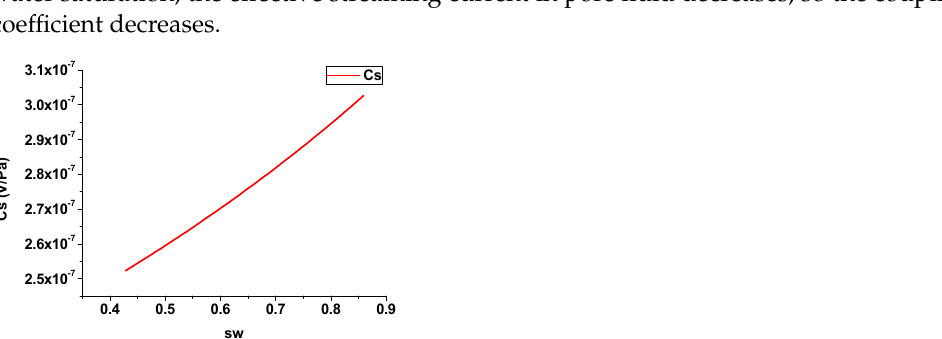
sw Cs1 Cs2 Cs3 Cs4 Cs5 Figure 9. Influence of water film thickness on streaming potential coupling coefficient (slug flow). Figure 10 studies the influence of pore size on the streaming potential coupling coef- ficient of the capillary under slug flow. The pore radius is taken as 0.2 μm , 0.4 μm , 0.6 μm , 0.8 μm , and 1 μm , respectively. It can be seen from the figure that the coupling coeffi- cient gradually increases with the increase in pore radius. As the pore radius increases, the streaming current will increase, and the change in pore fluid conductivity is small, so the coupling coefficient will become larger. 0.5 sw Cs1 Cs2 Cs3 Cs4 Cs5 Figure 10. Influence of pore size on streaming potential coupling coefficient (slug flow). Figure 11 investigates the effect of fluid salinity on the streaming potential coupling coefficient of the capillary in the slug flow case. The salinity is taken as 0.015 mol/L, 0.03 mol/L, 0.045 mol/L, 0.06 mol/L, and 0.075 mol/L, respectively. It can be seen from the fig- ure that the coupling coefficient gradually decreases with the increase in salinity. With the